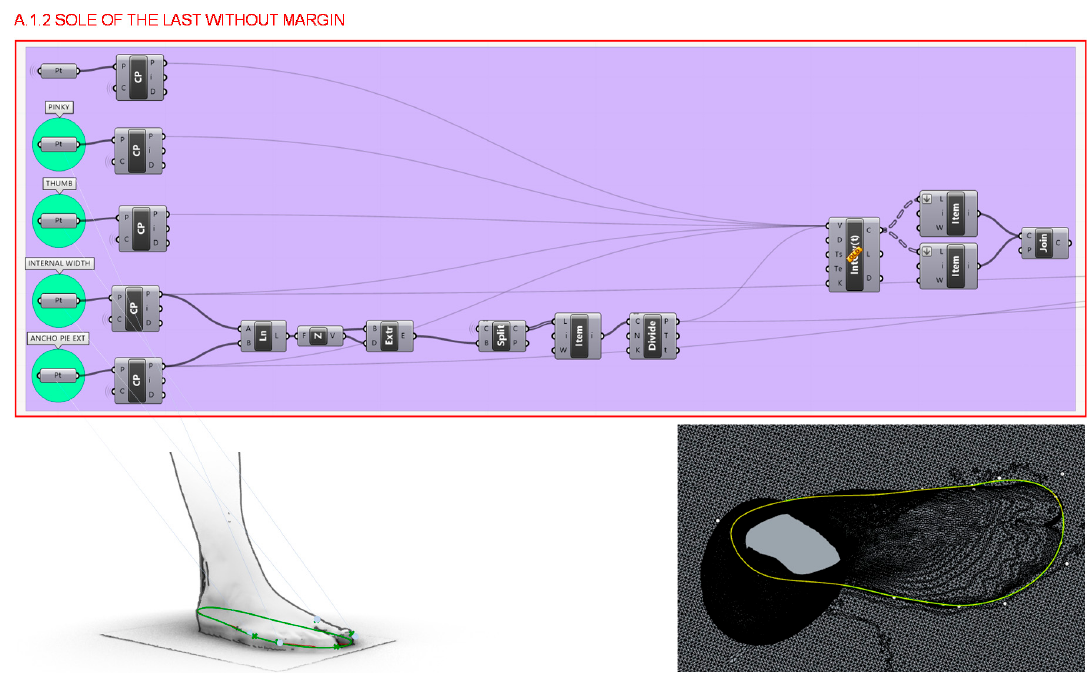
Figure 7. Programming structure definition to generate the sole of the last without gap.